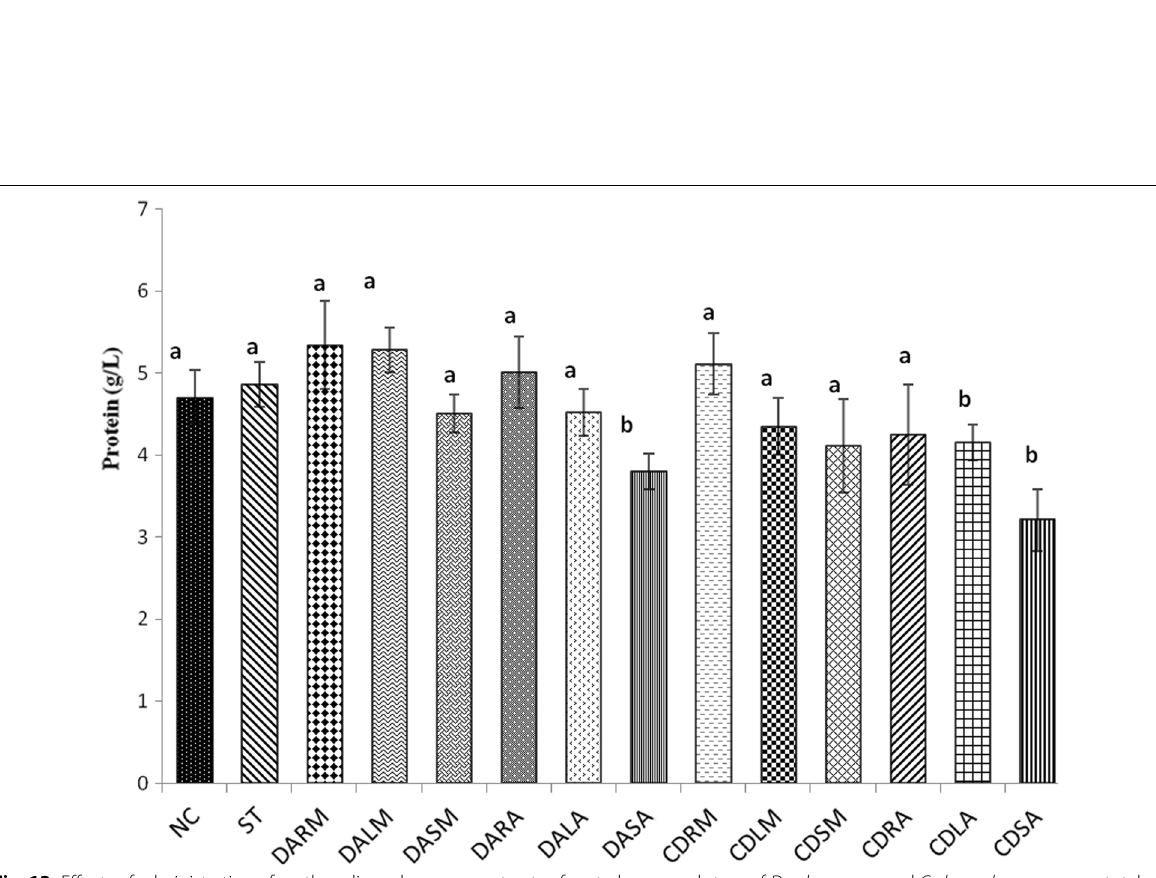
Fig. 13 Effects of administration of methanolic and aqueous extracts of roots, leaves and stem of D. arborescens and C. dependens on serum total protein of rats. Bars with similar alphabets are not statistically different ( p <